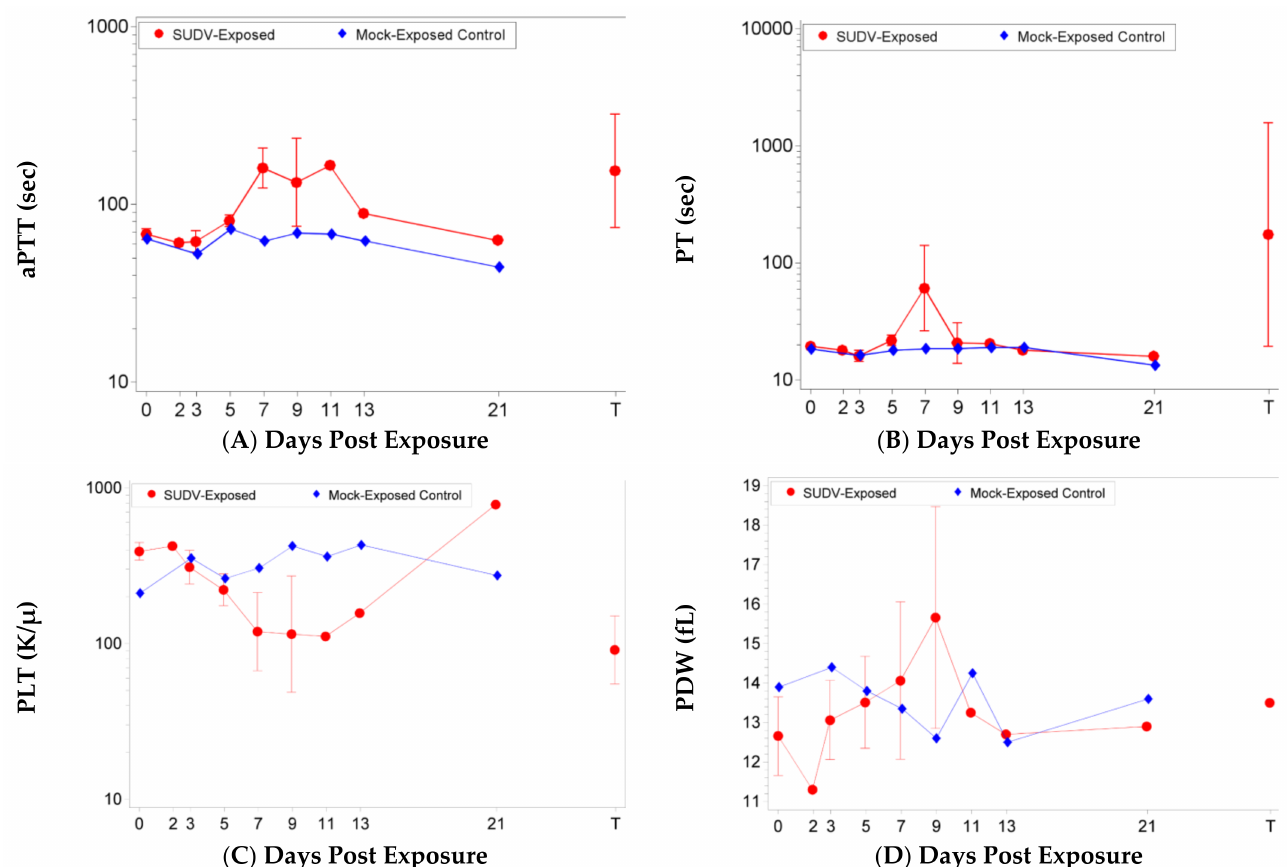
Figure 3. Coagulation parameters in SUDV-exposed and mock-exposed cynomolgus macaques. Mean with 95 percent confidence intervals; confidence interval was not plotted for sample size less than 3. Unless otherwise noted, values were log-transformed and the geometric mean is displayed. T represents Terminal (data collected from animals that met euthanasia criteria were combined and reported as a single terminal time point). ( A ) Activated partial thromboplastin time (aPTT). ( B ) Prothrombin time (PTT). ( C ) Platelet counts. ( D ) Platelet distribution width (PDW), (values not